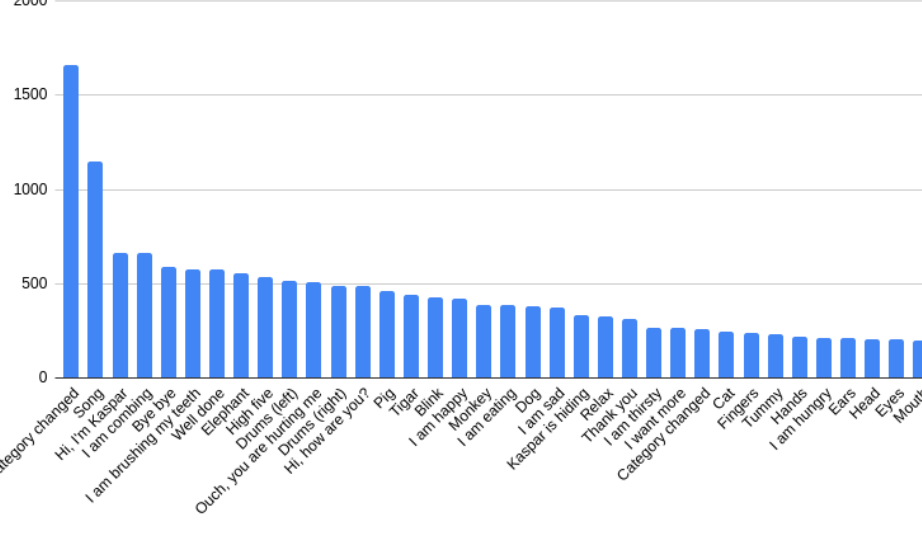
Figure 11. The most played